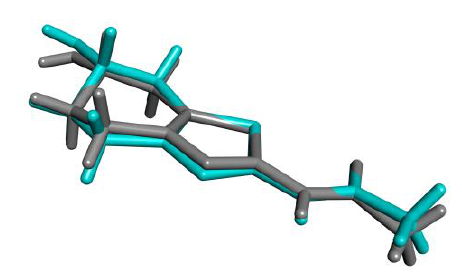
Figure 5. Superposition of the two independent molecules of the asymmetric unit of ( S )- 4 .